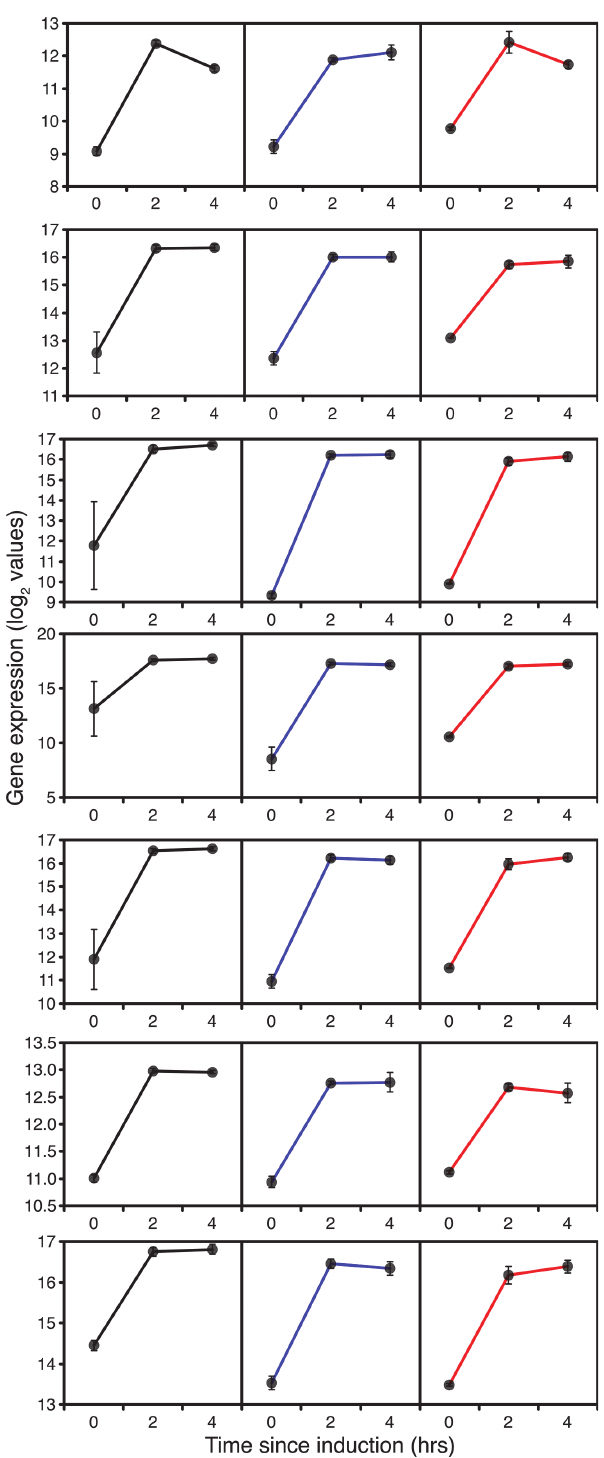
Fig 2. Expression of genes associated with methanol oxidation and assimilation during fed-batch culture, 0 (before), 2 and 4 hours after the start of methanol addition to wild-type GS115 (black), TRY1- 1 (blue) and TRY1-3 (red), strains containing 1 and 3 gene copies of the human typsinogen gene, respectively, under the control of the AOX1 promoter. From top to bottom, panels represent AOX1 , FDH1 , FGH1 , DAS1 , DAK2 , TPI1 and RIB1 . Error bars show